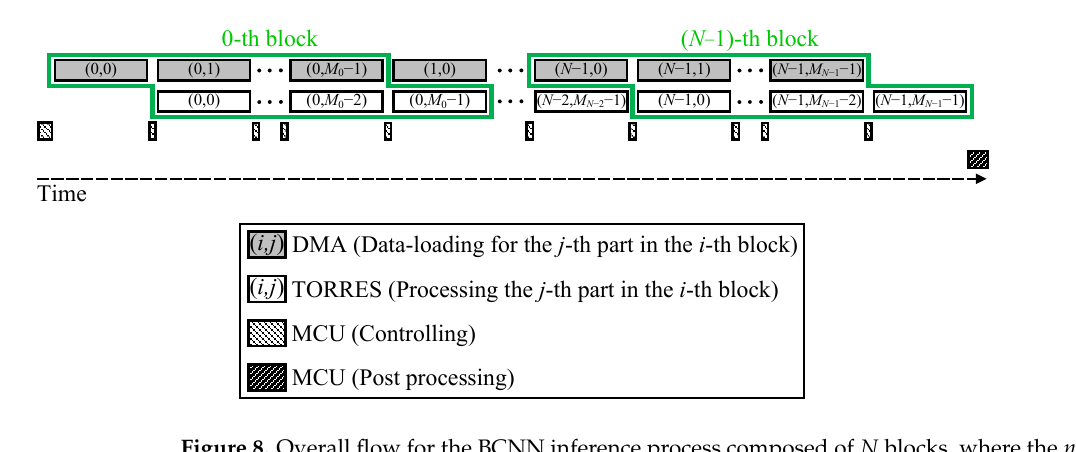
Figure 8. Overall flow for the BCNN inference process composed of N blocks, where the n -th block is processed by being decomposed into M n parts.